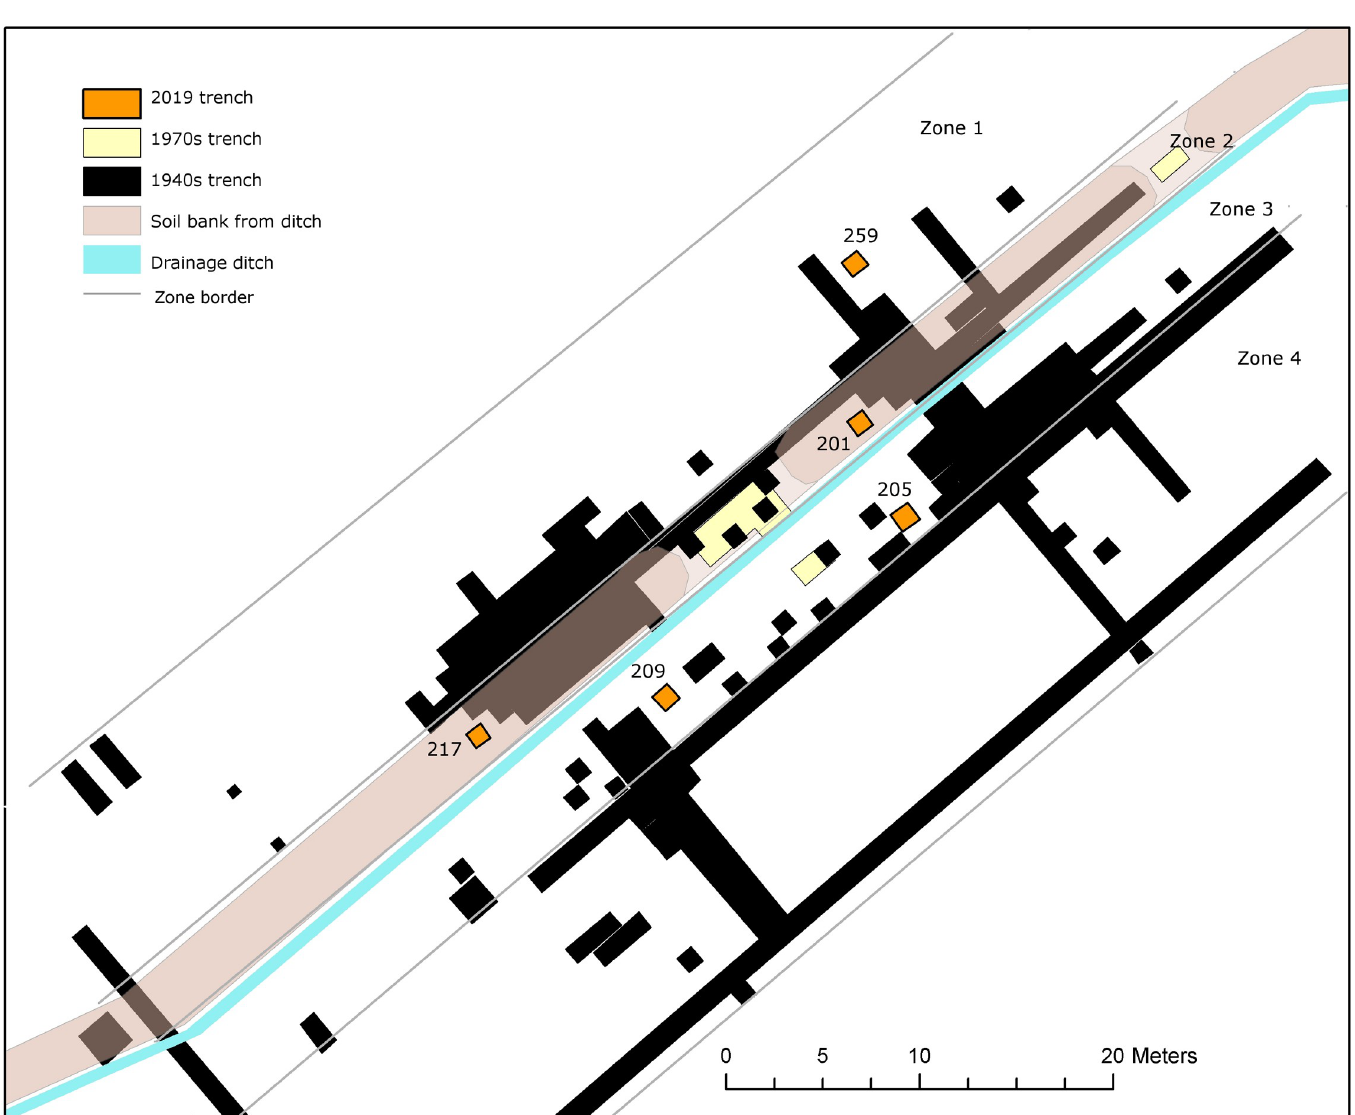
Fig 4. The square meter trenches from 2019 in relation to the former excavation trenches, the ditch draining the bog and the soil bank of excavated ditch material from its establishment and maintenance. The zone division was arbitrarily selected to study differences in bone preservation between the driest (zone 1) and the wettest (zone 4)